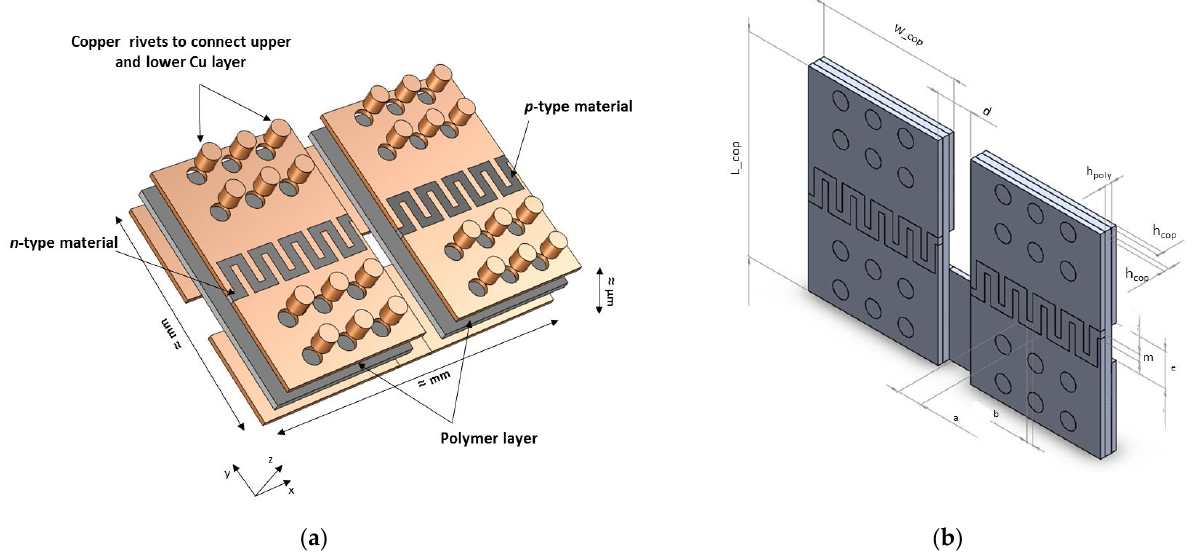
Figure 1. ( a ) Design of the μ‐ TEG integrating n ‐ and p ‐ type Bi 2 Te 3 ‐ based materials; ( b ) typical dimensions of the μ‐ TEG are indicated.